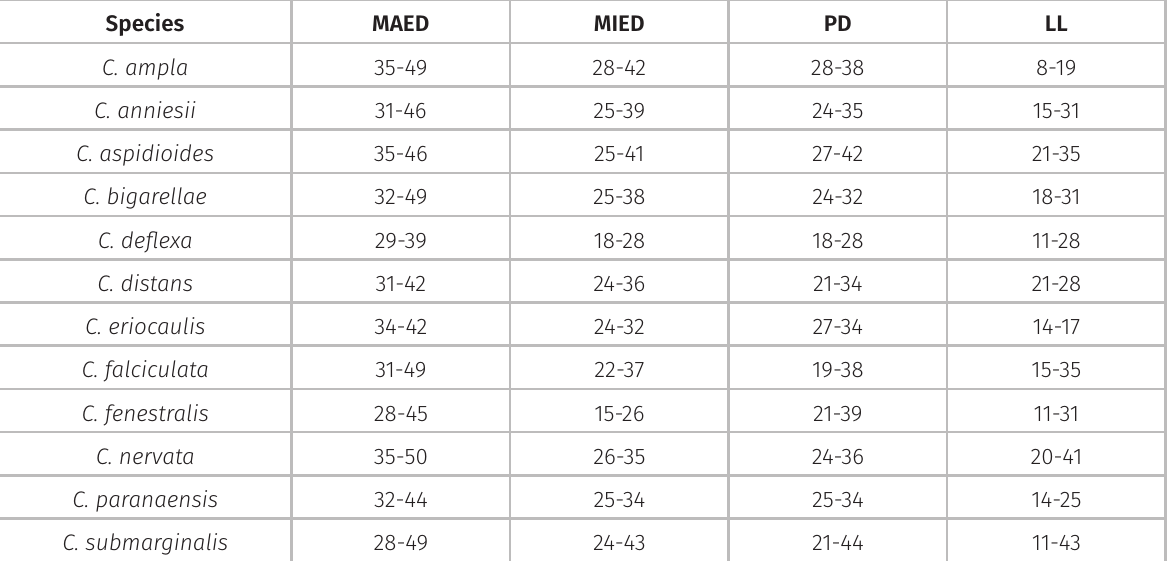
are monolete, of bilateral symmetry and light to dark brown color. The outline is ellipsoidal or sub-circular in polar view and plane-convex to convex-subhemispheric in equatorial view. C. ampla: The spores are light brown (Fig. 1a). Ellipsoidal to subcircular in polar view and plane-convex to convex-subhemispheric in equatorial view. The exospore is 0.9-1.2 μm thick and smooth. The laesura is delicate and due to the density of the sculptural elements it is not very visible (Fig. 2b). The sculpture is echinate (Figs. 2a, 2b), formed by conical spines, with a broad base and attenuated apex, of 3.9- 8.8 μm height, up to 1.2 μm wide at the apex and 3.1-5.7 μm wide base. The bases are coalescent with each other and this union can occur by small cords or not (Fig. 2c). The tips of the spines appear broken, showing that they are hollow inside (Fig. 2c). C. anniesii: The spores are light brown (Fig. 1b). Ellipsoidal in polar view and plane to convex in equatorial view. The exospore is 0.5-0.7 μm thick and smooth. The sculpture is folded, formed by subglobose and sinuous folds of Table I. Ctenitis species spore measurements from Southern Cone of South America. Dimensions in μm. Species MAED